Question: What type of chart is this?
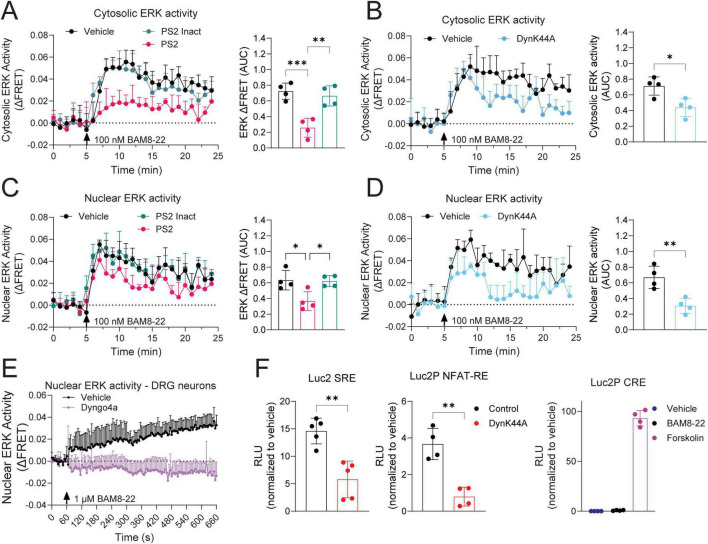
Answer: line